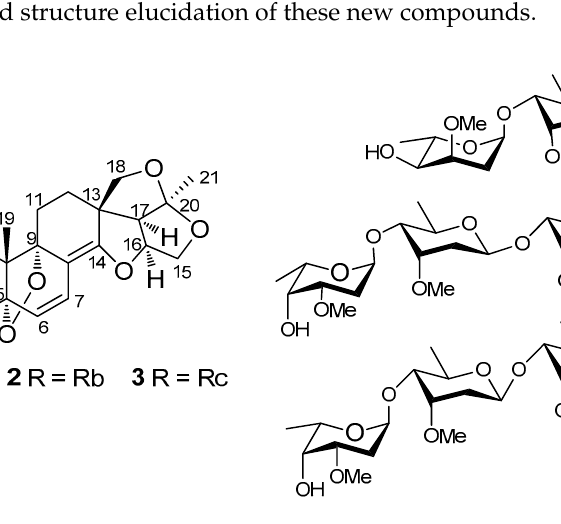
Figure 1 . Structures of compounds 1–3 . Figure 1. Structures of compounds 1 – 3